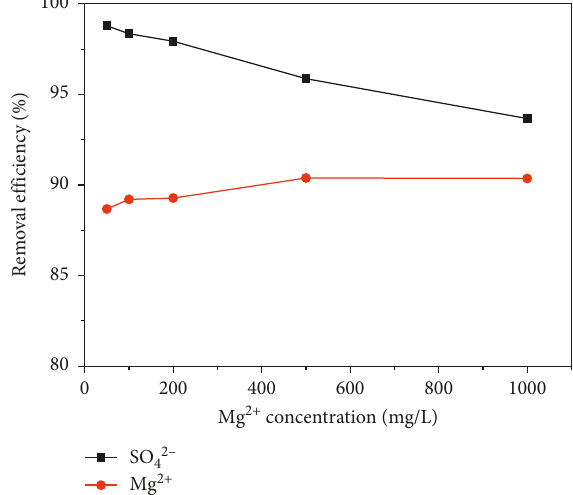
Figure 11: The effect of Mg 2+ concentration. V Al :S) 4:1 :1, v (cid:27)